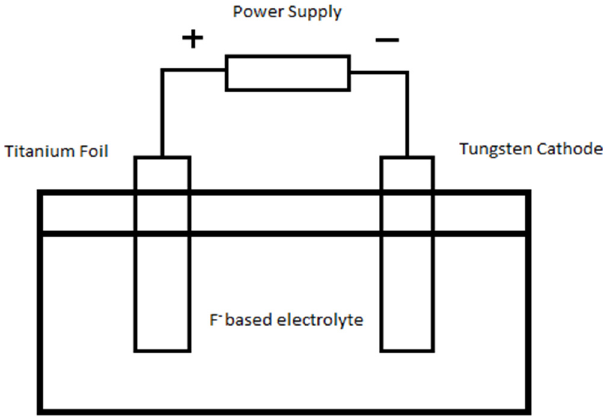
Figure 8. Schematic drawing of an electrochemical cell in which the Ti electrode is